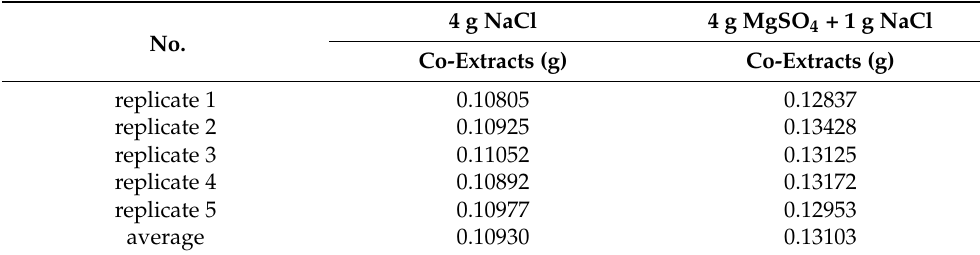
Table 2. Weight of 5 mL co-extracts in the two salts’ composition.